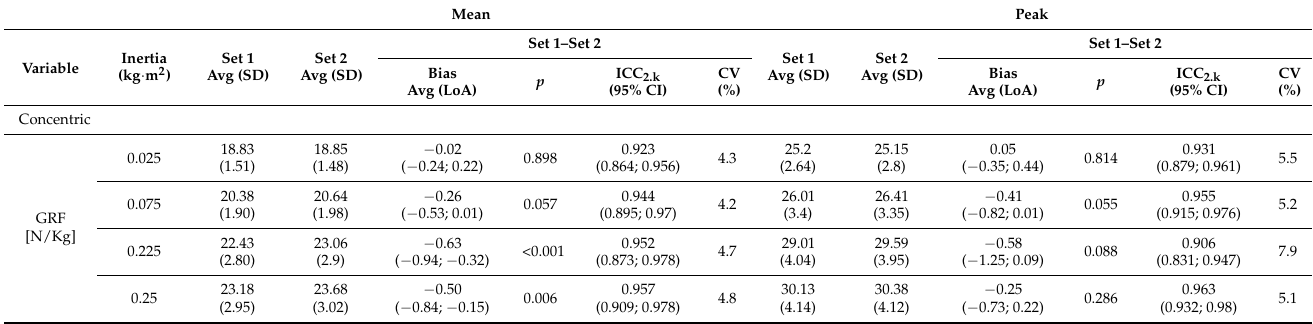
Table A1. Descriptive statistics and inter-set reliability of the observed rotary encoder